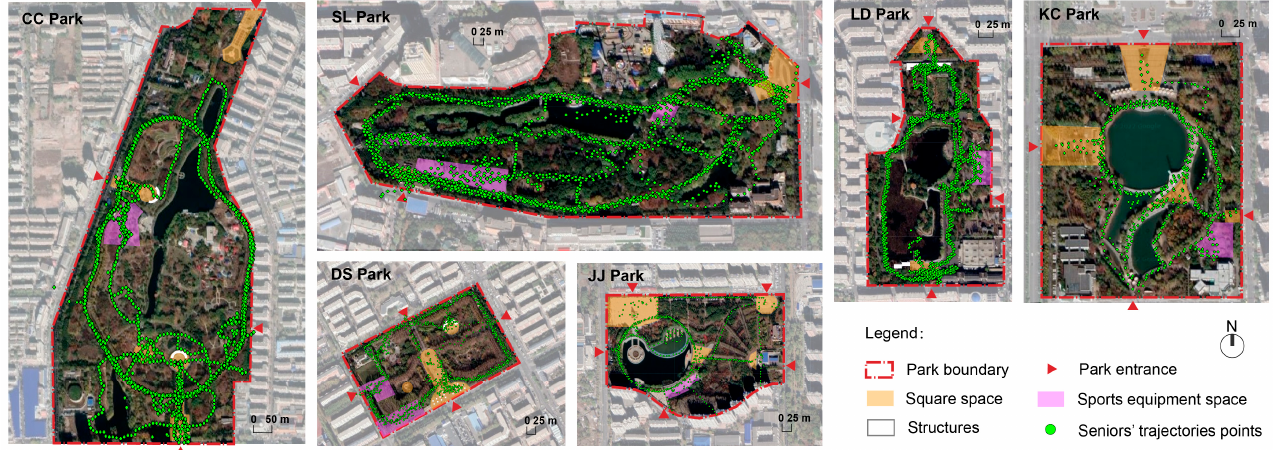
Figure 3. Maps of sample parks and older adults’ sample trajectories. Table 2. Park design characteristics and behavior characteristics.